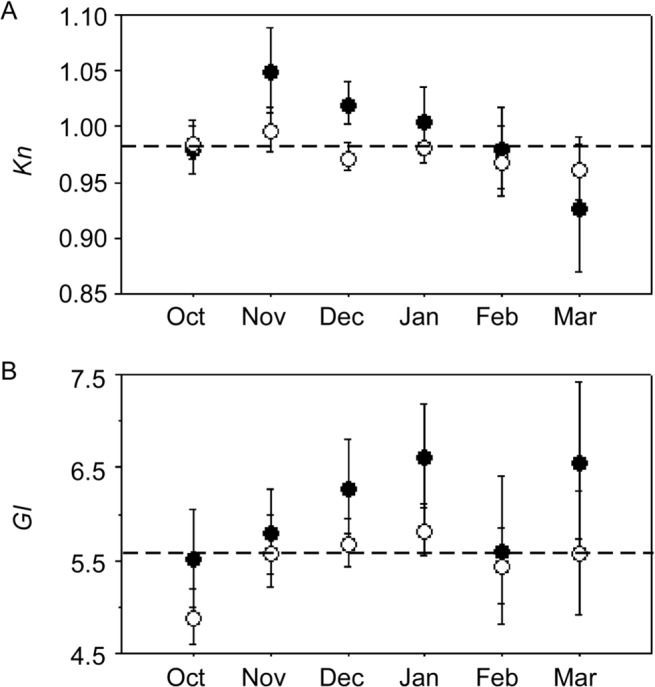
Seasonal variation in mean relative condition factor (Kn) (A) and gonad index (GI) (B).Non-spawning females = ●, actively spawning females = ○. Results are not shown for months where n ≤ 10. Females with hydrated oocytes were excluded from the GI analysis to remove the effect of heavy hydrating ovaries. Dashed line indicates the mean for all females. Error bars are ± 2 S.E.